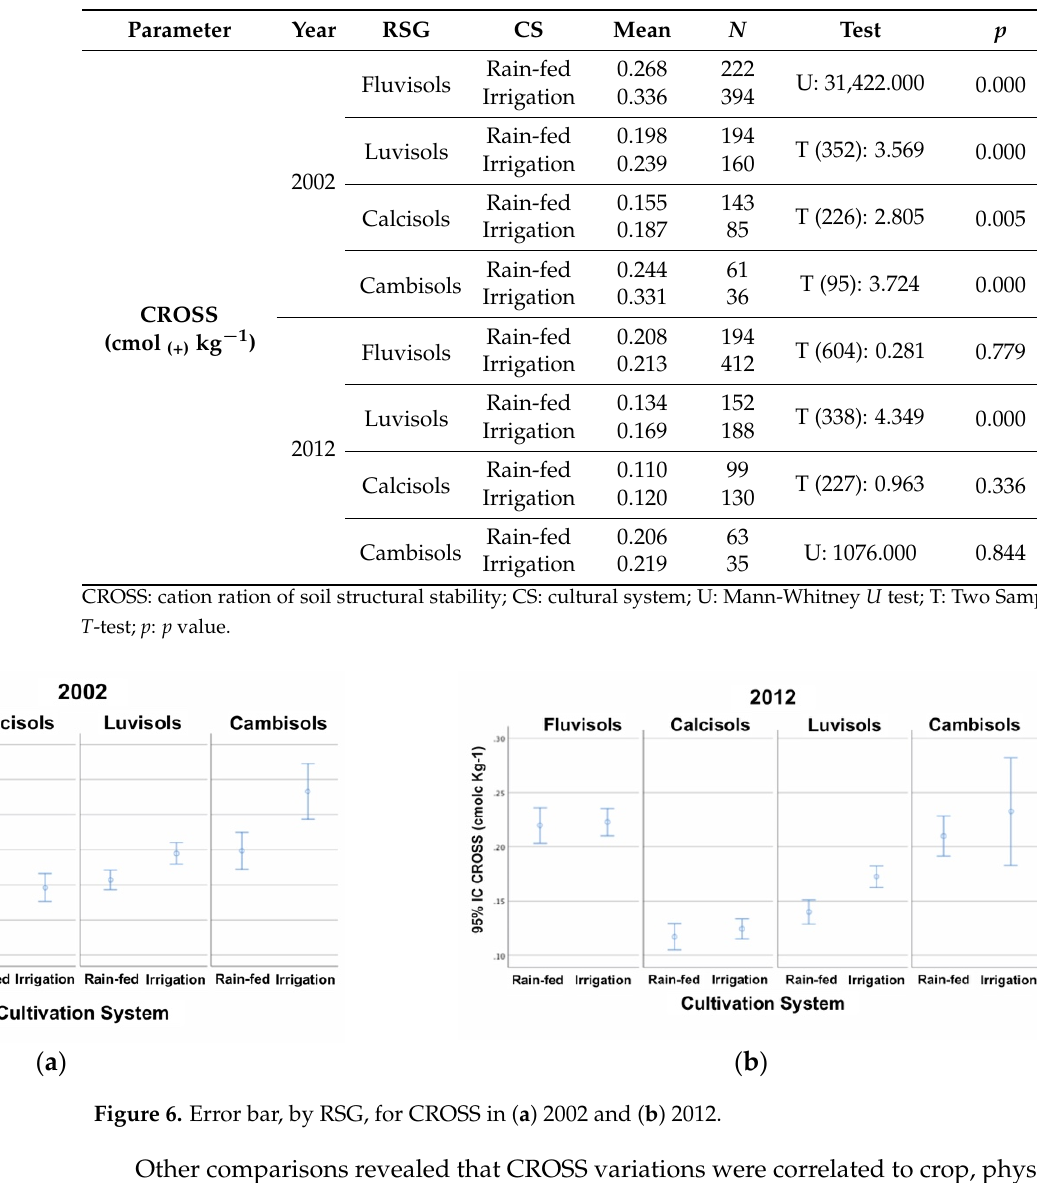
Table 7. CROSS evolution from 2002 to 2012.